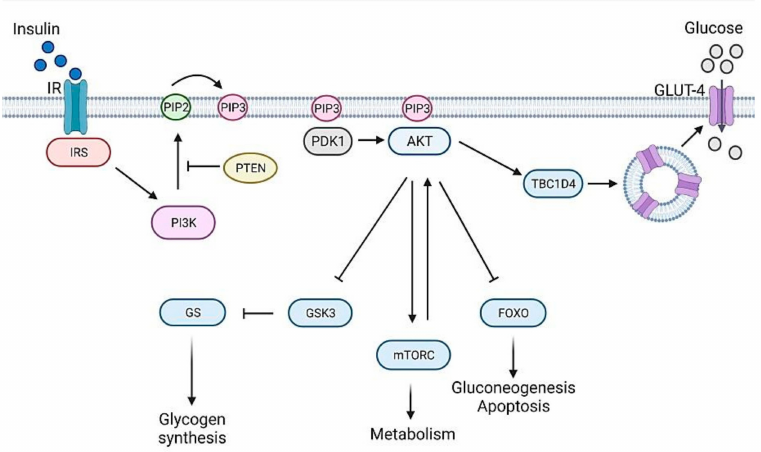
Figure 2. The mammalian insulin signaling pathway, a simplified schematic representation. Insulin receptor (IR) through insulin receptor substrate (IRS) creates binding sites that recruit the lipid kinase phosphoinositide 3-kinase (PI3K) to the plasma membrane. PI3K phosphorylates phosphatidyli- nositol 4,5-bisphosphate (PIP2) to produce phosphatidylinositol 3,4,5-trisphosphate (PIP3), which can be dephosphorylated back to PP2 by phosphatase and tensin homologue (PTEN), a lipid phos- phatase. PIP3 recruits phosphoinositide-dependent kinase 1 (PDK1) and serine/threonine protein kinase AKT to the plasma membrane, where AKT is fully activated by PDK1 and by mechanistic target of rapamycin complex (mTORC) protein kinases. AKT controls cellular metabolism through key downstream substrates. In particular, AKT inhibits the activity of GSK3, thus stimulating the glycogen synthesis by glycogen synthase (GS). In addition, it promotes the translocation of GLUT4 to the plasma membrane, through TBC1 domain family member 4 (TBC1D4), thus favoring glucose uptake; AKT prevents gluconeogenesis and apoptosis by controlling the activity of fork- head box O (FOXO) transcription factors; AKT controls cell growth and metabolism by regulating mTORC activity. Figure 2 was created with BioRender.com (https://app.biorender.com, accessed on 15 September 2021).